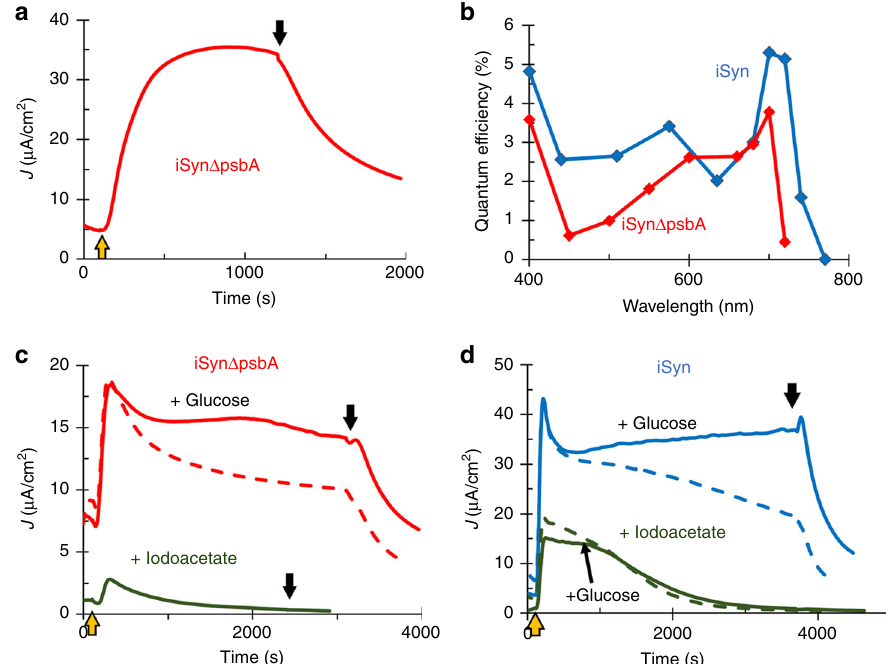
Fig. 4 iSyn photocurrent to the BPEC involves both photosynthetic and respiratory systems. a CA measurements for iSyn Δ psbA. b Action spectra: the obtained photocurrent was normalized to the photon energy input (external quantum ef fi ciency) at different wavelengths. The external quantum ef fi ciency of iSyn is shown in blue and that of iSyn Δ psbA in red. A new measurement with fresh cells was used for each wavelength. c CA measurements for iSyn Δ psbA without (red) and with (green) the addition of iodoacetate and in the presence (full line) or absence (dashed line) of glucose. d CA measurements for iSyn without (blue) and with (green) the addition of iodoacetate or in the presence (full line) or absence (dashed line) of glucose in the